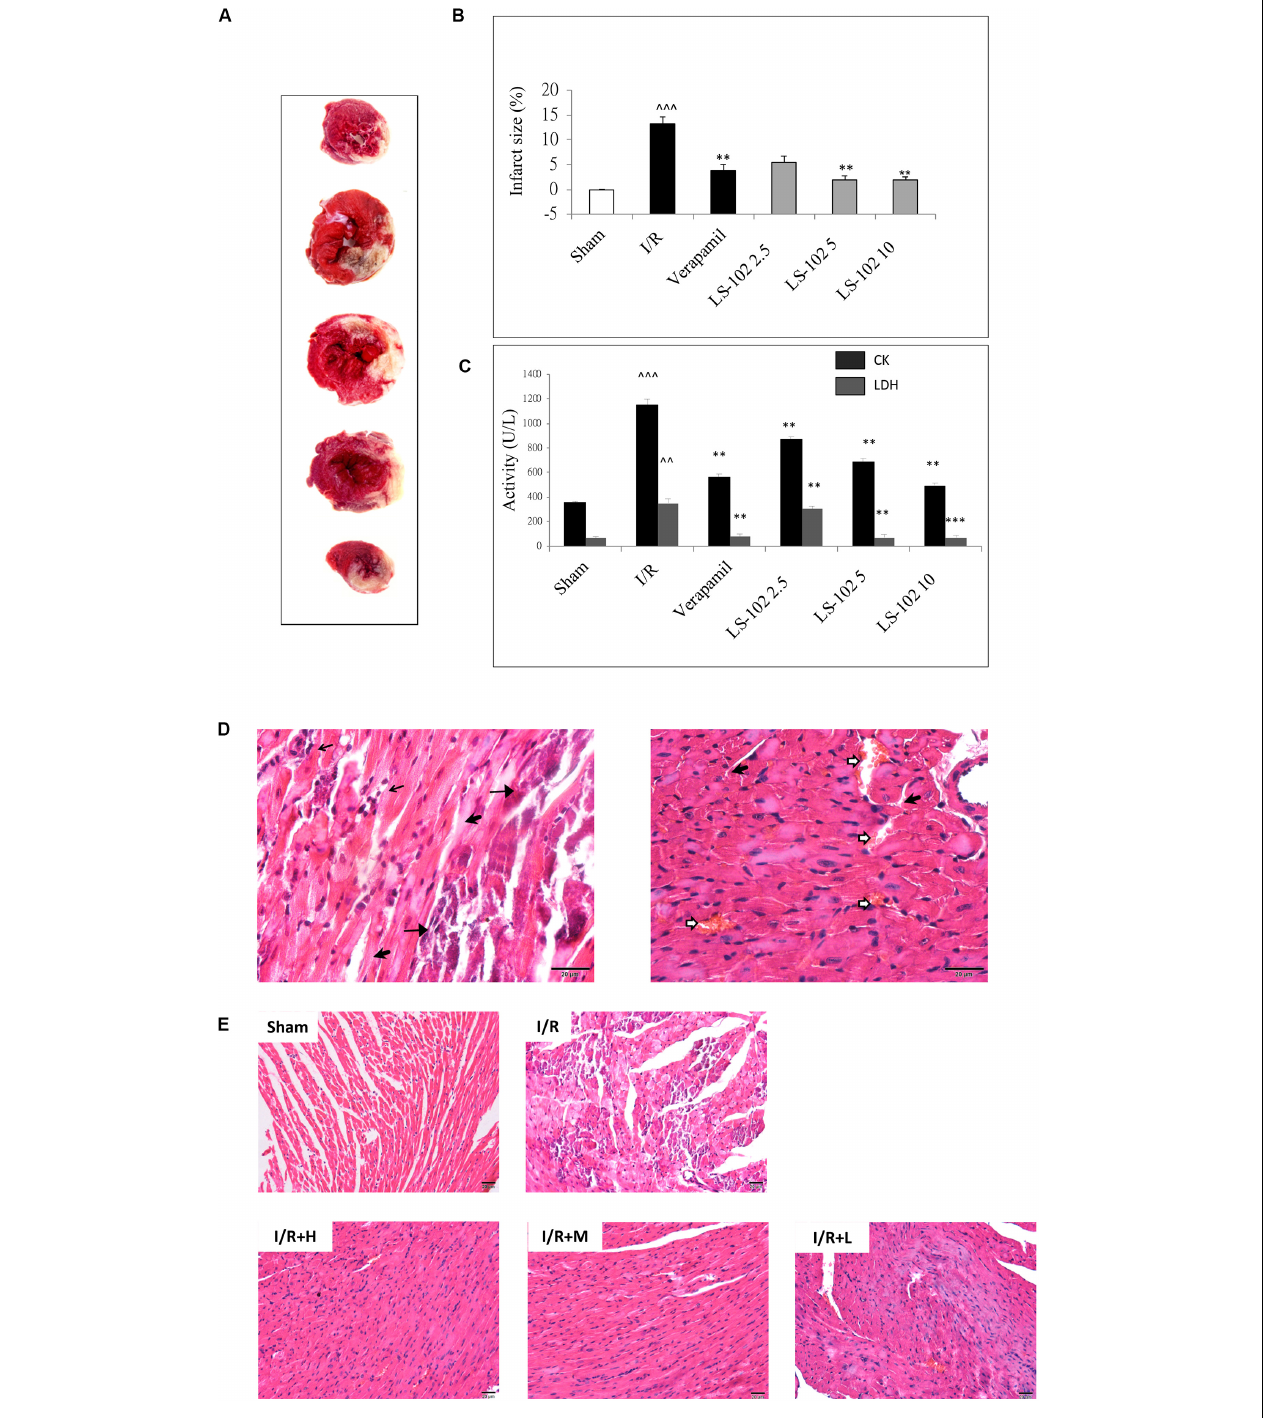
FIGURE 2 | Oral-administration of LS-102 exhibited a dose-dependent relationship of cardioprotective effect in rat heart. (A) Representative image of TTC staining sections of the left ventricle. The viable tissue was stained as red area and the unstained pale areas were presumed to be infarcted tissue. (B) Bar chart of infarct size (%). (C) The activities of CK and LDH in serum were detected. (D) Representative high power views of I/R myocardial tissue slice showing neutrophil polymorphs flooding the infarcted area (thin arrow), infarcted cardiomyocytes appearing deeply eosinophilic with loss of cross striations (arrow head), prominent interstitial edema (thick arrow), RBCs in the interstitial spaces (open arrow). (E) Illustration of H&E staining of the myocardial tissue in different groups (200 × magnification). Sham and I/R, distilled water 8ml/kg; LS-102 2.5, LS-102 2.5 mg/kg; LS-102 5, LS-102 5 mg/kg; LS-102 10, LS-102 10 mg/kg. Data are shown as mean ± SEM, n = 8–10/group. ˆˆˆ P < 0.001, ˆˆ P < 0.01, vs. Sham group, *** P < 0.001, ** P < 0.01 vs. I/R group.